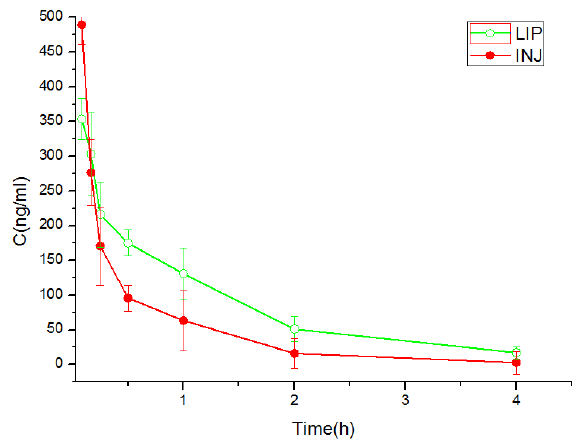
Figure 3 : Plasma concentration-time profiles of GB. GB-LM (○ ) and the commercial product (● ). Each value represents the mean ± S.D. (n = 8).